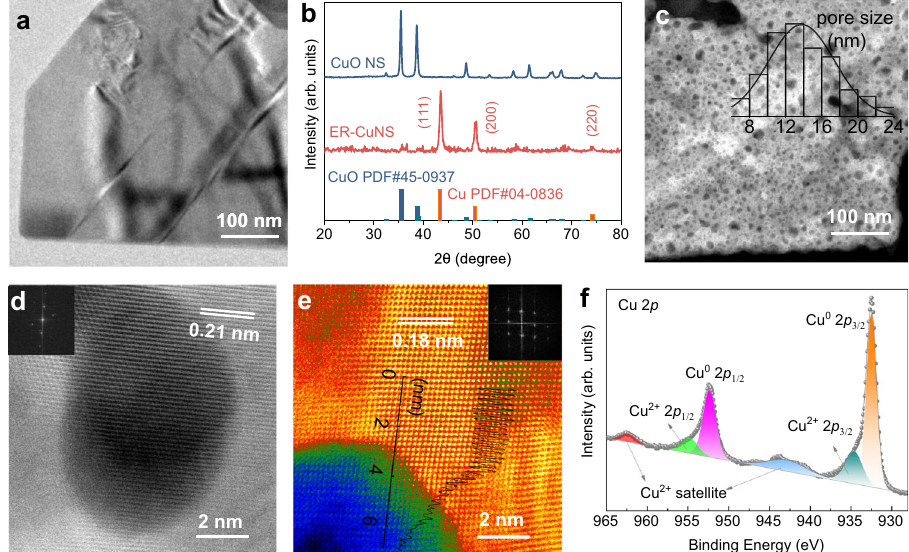
Fig. 1 | Structural characterizations. a Low-magni fi cation TEM image of as- preparedCuONS. b XRDpatternsofCuONSandER-CuNSwithstandardPDFcards of CuO and Cu. c HAADF-STEM imageof ER-CuNS.Theinsetisthesizedistribution